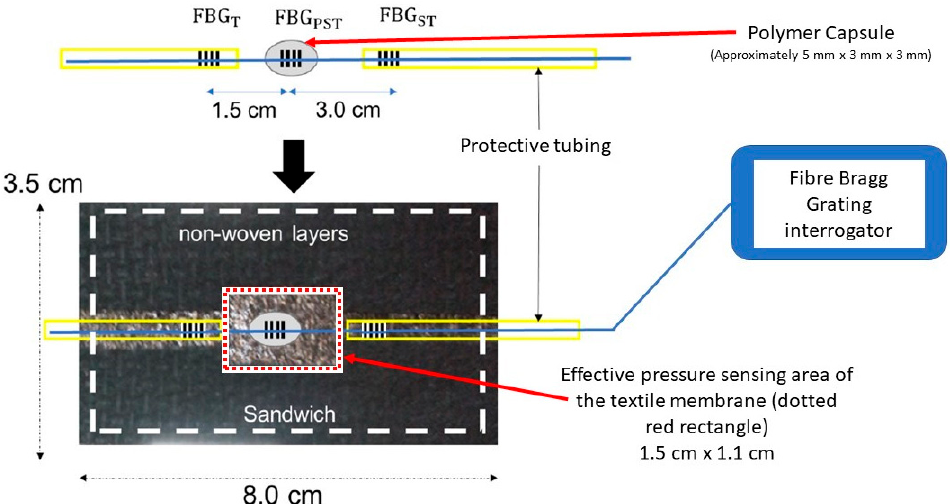
Figure 1. Schematic of the optical fibre-based pressure sensor. An FBG (FBG PST ) is encapsulated in a polymer to transduce applied pressure into a measurable strain–effective pressure sensing area shown in a red rectangle. Two reference FBGs (FBG ST and FBG T ) sensitive to strain and temperature respectively are used to compensate for these effects on the pressure measurements. The sensors are enclosed in a textile ‘sandwich’ and are connected to an interrogator unit via an optical fibre patch cord.